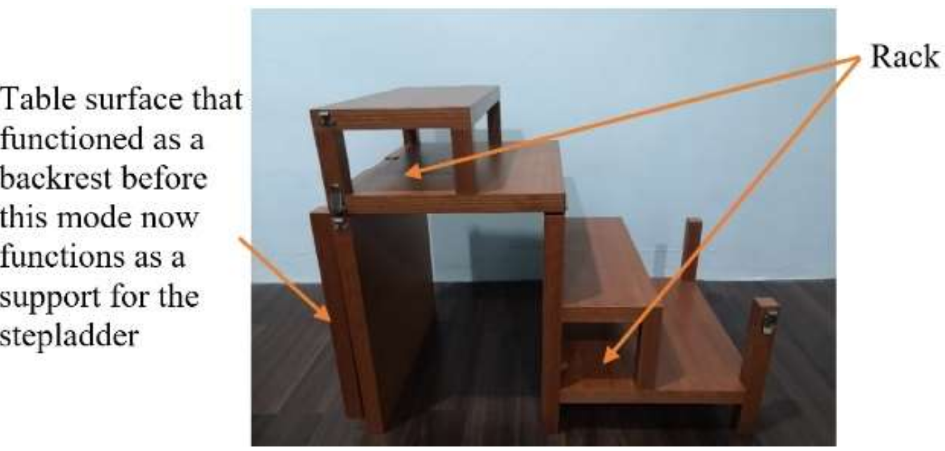
Figure 16. Final prototype—stepladder